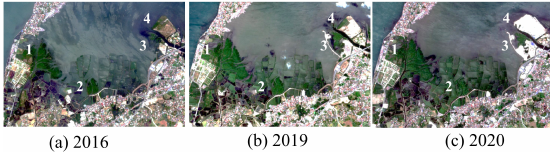
Figure 1. Sentinel-2 images covering the study area in 2016, 2019, and 2020 (1: Brgy. San Rafael, Noveleta; 2: Brgy. Poblacion, Kawit; 3: Brgy. Pulvorista, Kawit; 4: Brgy. Binakayan, Kawit)